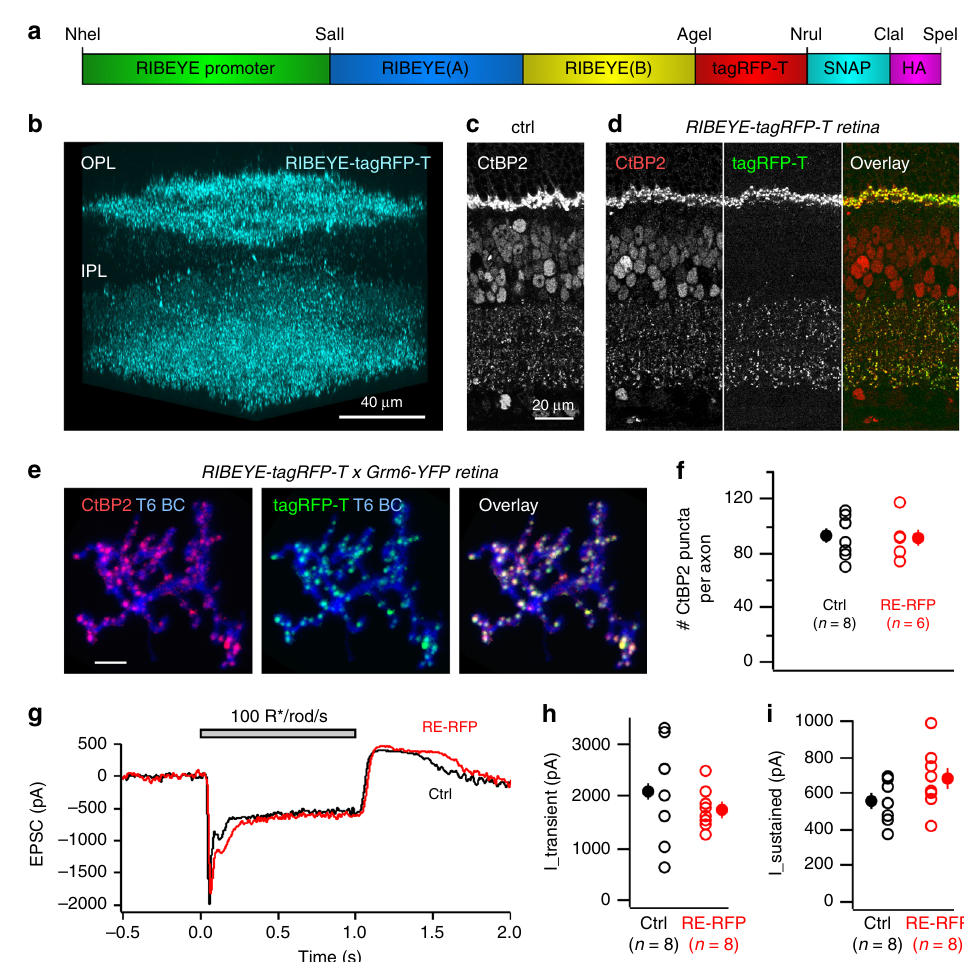
Fig. 2 RIBEYE-tagRFP-T mice enable visualization of ribbons in live retina. a A schematic drawing of the RIBEYE-RIBEYE:tagRFP-T transgene. b Volumetric view of a two-photon reconstruction of RIBEYE-tagRFP-T live retina. OPL outer plexiform layer. IPL inner plexiform layer. c Vertical section of CtBP2 labeling in control (ctrl) retina. d Vertical section of CtBP2 labeling, RIBEYE-tagRFP-T (tagRFP-T), and overlay of both channels. e Colocalization of CtBP2 labeling and RIBEYE-tagRFP-T signal on a type 6 BC axon terminal. f Comparison of number of CtBP2 puncta on T6 BC axon terminal in control (ctrl; Grm6-YFP ; eifht cells from eight retinas) and RIBEYE-tagRFP-T (RE-RFP) (six cells from four retinas) mice. g An example of light-evoked EPSC on ON-alpha RGCs in control and RIBEYE-tagRFP-T mice. Quanti fi cation of the amplitude of the transient ( h ) and sustained ( i ) components of the light-evoked EPSC. ( f , h , and i : n number of cells, from three retinas for each group). P21 mice were used in all experiments. Data are presented as mean ±